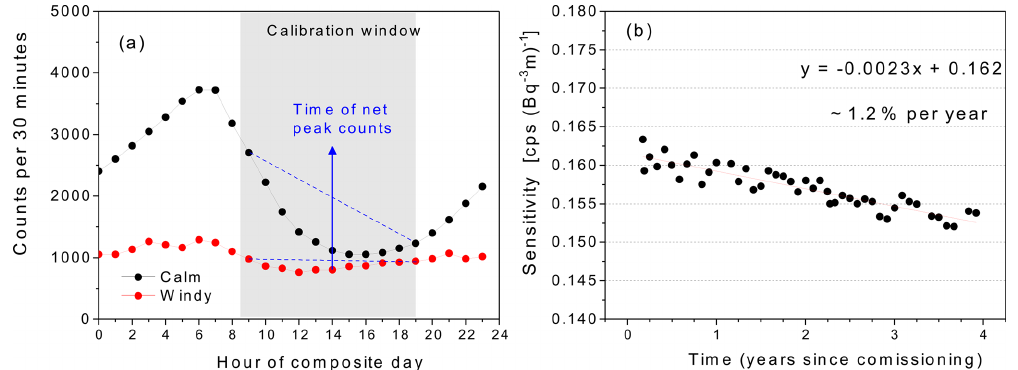
Figure 7. (a) Comparison of error in net peak count rate estimate associated with assuming a linear change in ambient radon concentration over a 10h calibration window on a calm vs. windy day, and (b) example of the deterioration of sensitivity to radon with time for a 700L two-filter dual flow-loop detector operating at Macquarie Island, in the mid-Southern